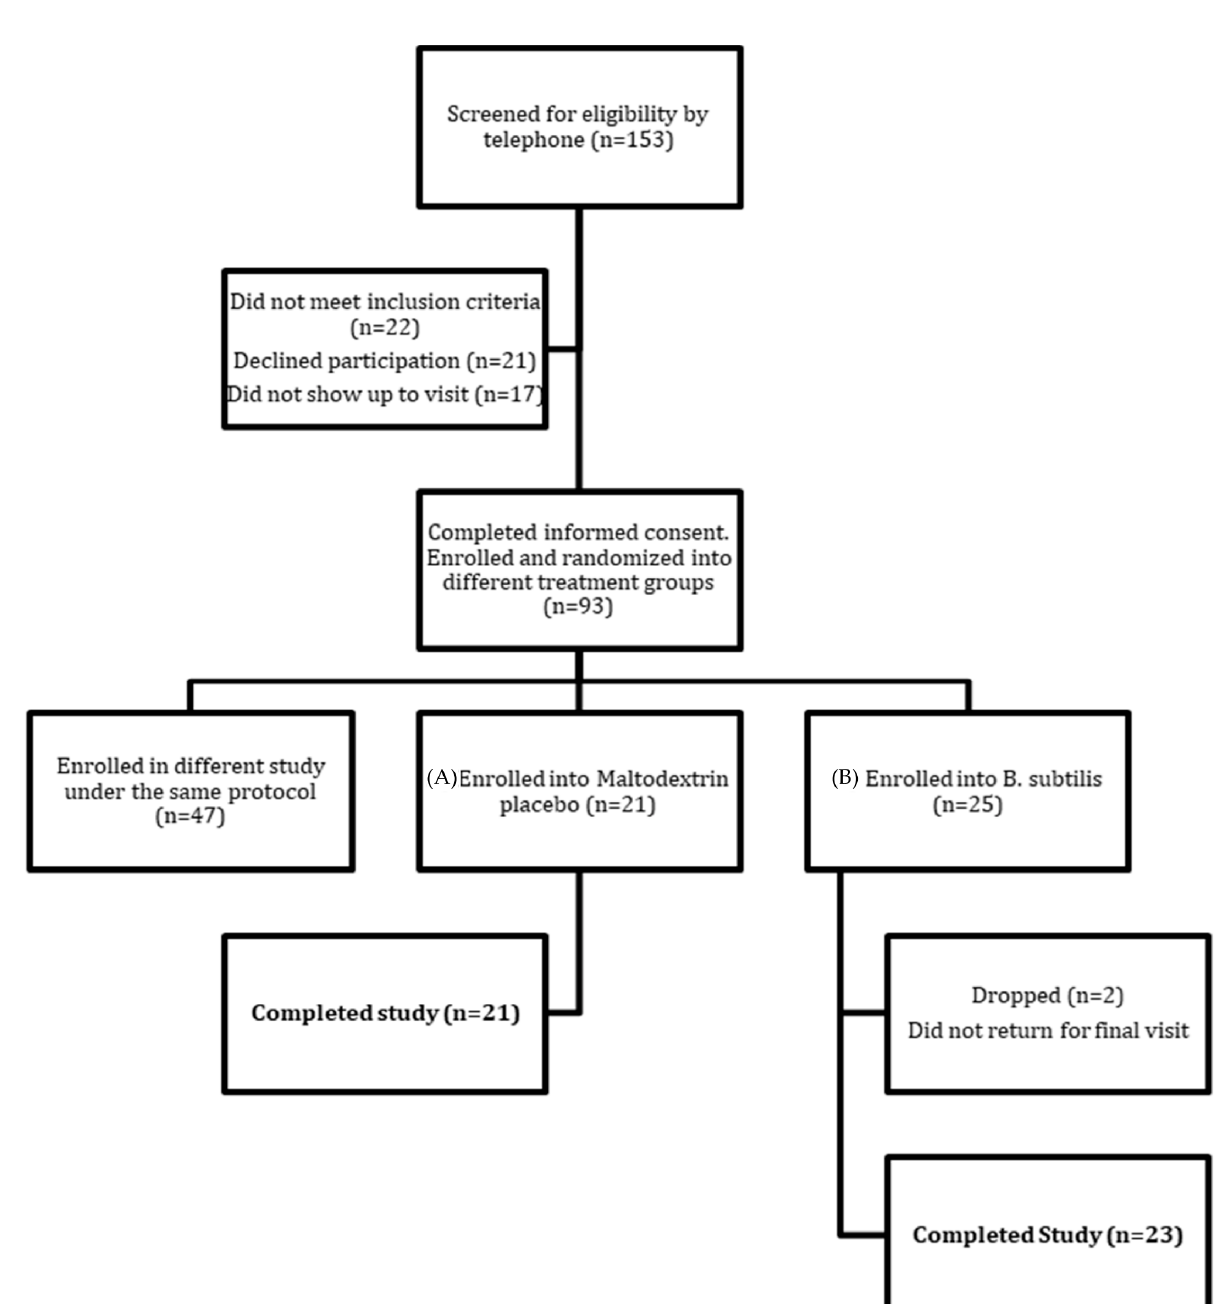
Figure 1. Consort flow diagram of study recruitment, randomization and completion.